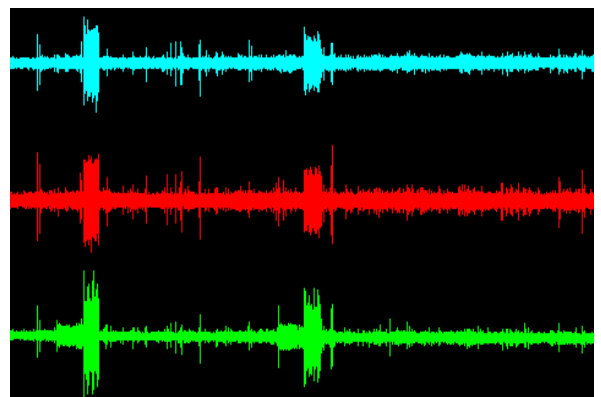
Figure 11. Vibration waveform in real time